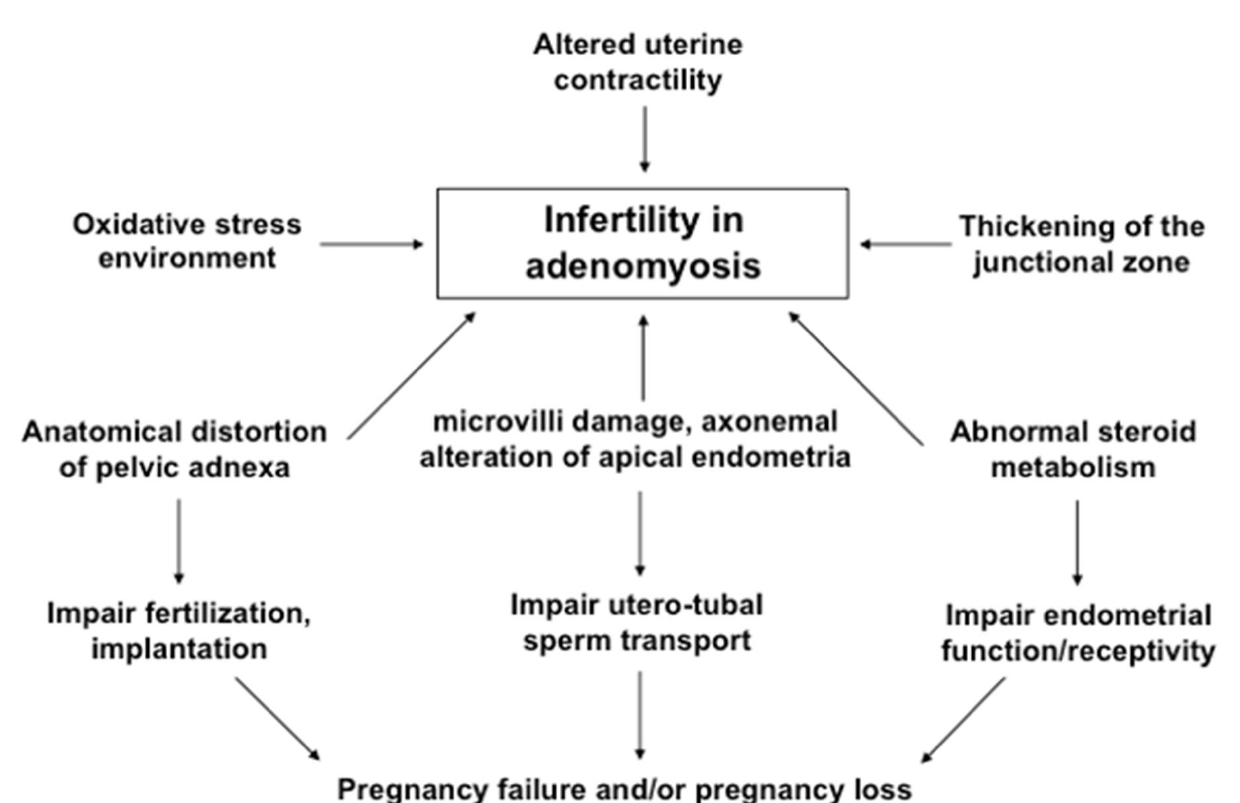
Figure 3. Represents different mechanistic bases that have been proposed and may be involved in the occurrence of negative fertility outcome in women with adenomyosis. the occurrence of negative fertility outcome in women with